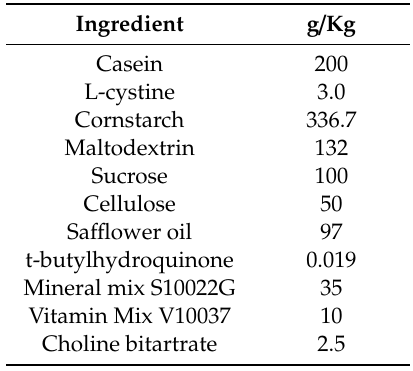
Table 1. Composition of 10% sa ffl ower diet fed to wildtype (WT) and fat-1